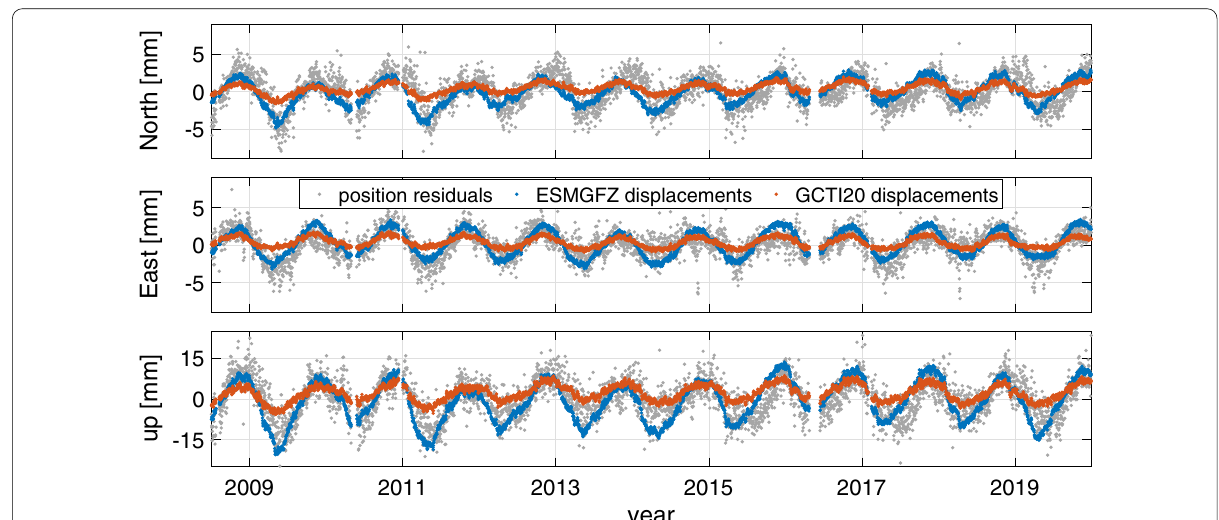
Fig. 10 Position residuals (grey) and combined (NTAL by GCTI20 (red) and ESMGFZ (blue) for the GNSS station SALU in Sao Luis, Brazil. Please note the different scale for the up